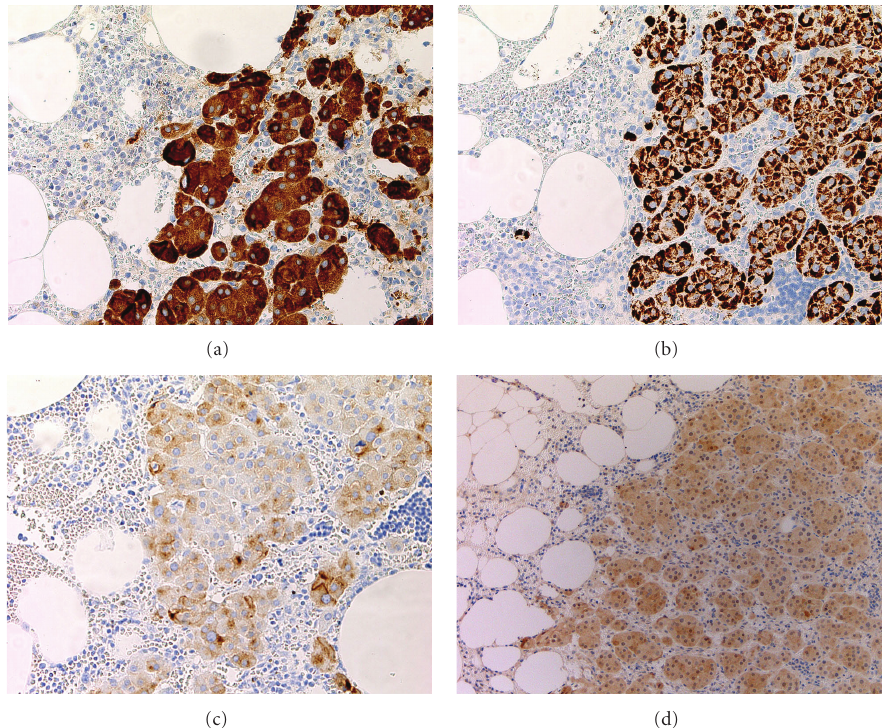
Figure 3: Immunohistochemical stains were strongly postive for Inhibin ((a), 200x) and Melan-A ((b), 200x) with weak positive staining for synaptophysin ((c), 200x) and calretinin ((d),